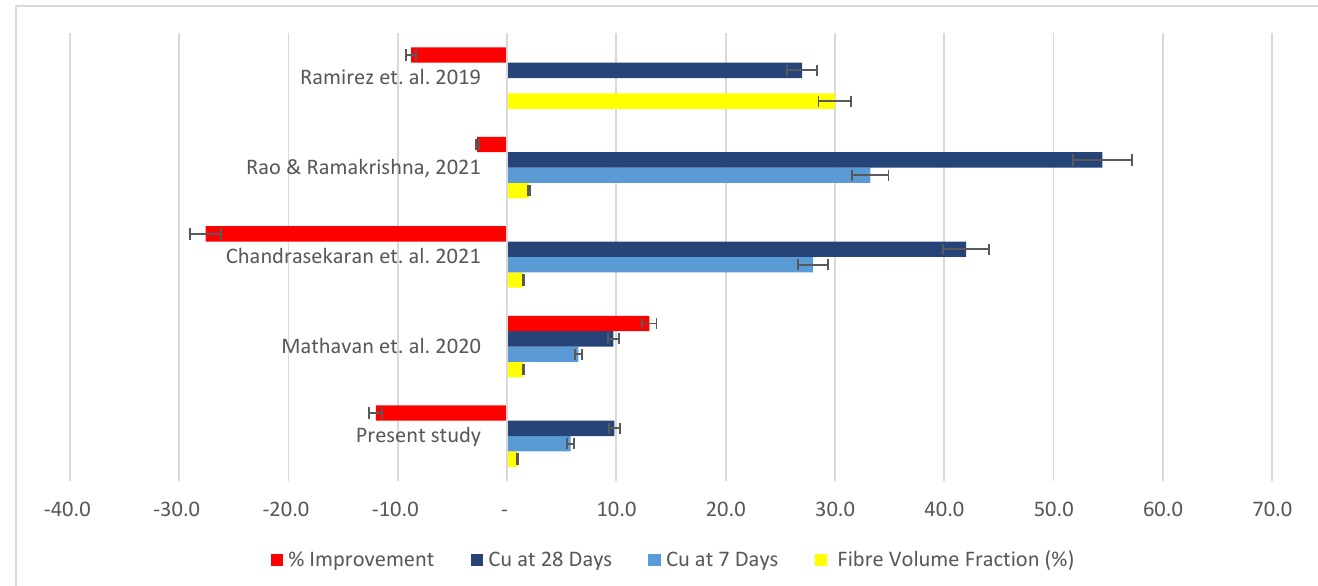
Figure 11. Chart expressing comparison of present study with previous studies in terms of optimal compressive strength values and improvement attained [22,32 – 34]. Table 5. Comparison of present with previous studies in terms of optimal compressive strength values and improvement attained [22,32 – 34].